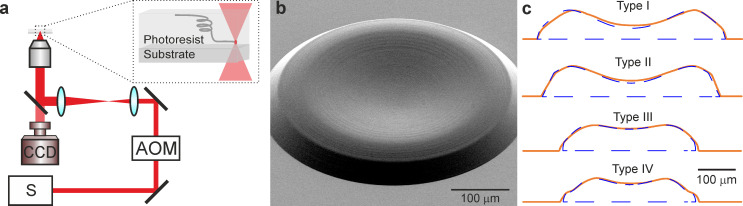
Polymer lens fabrication using 3D micro-printing based on two-photon lithography.(a) Schematic of the optical set-up for two-photon lithography. AOM, Acousto Optical Modulator; S, laser source; CCD, camera. (b) Scanning electron microscope image of a corrective polymer lens. (c) Blue dashed lines indicate the designed lens profile. Red lines represent the lens profile measured with a contact stylus surface profiler.